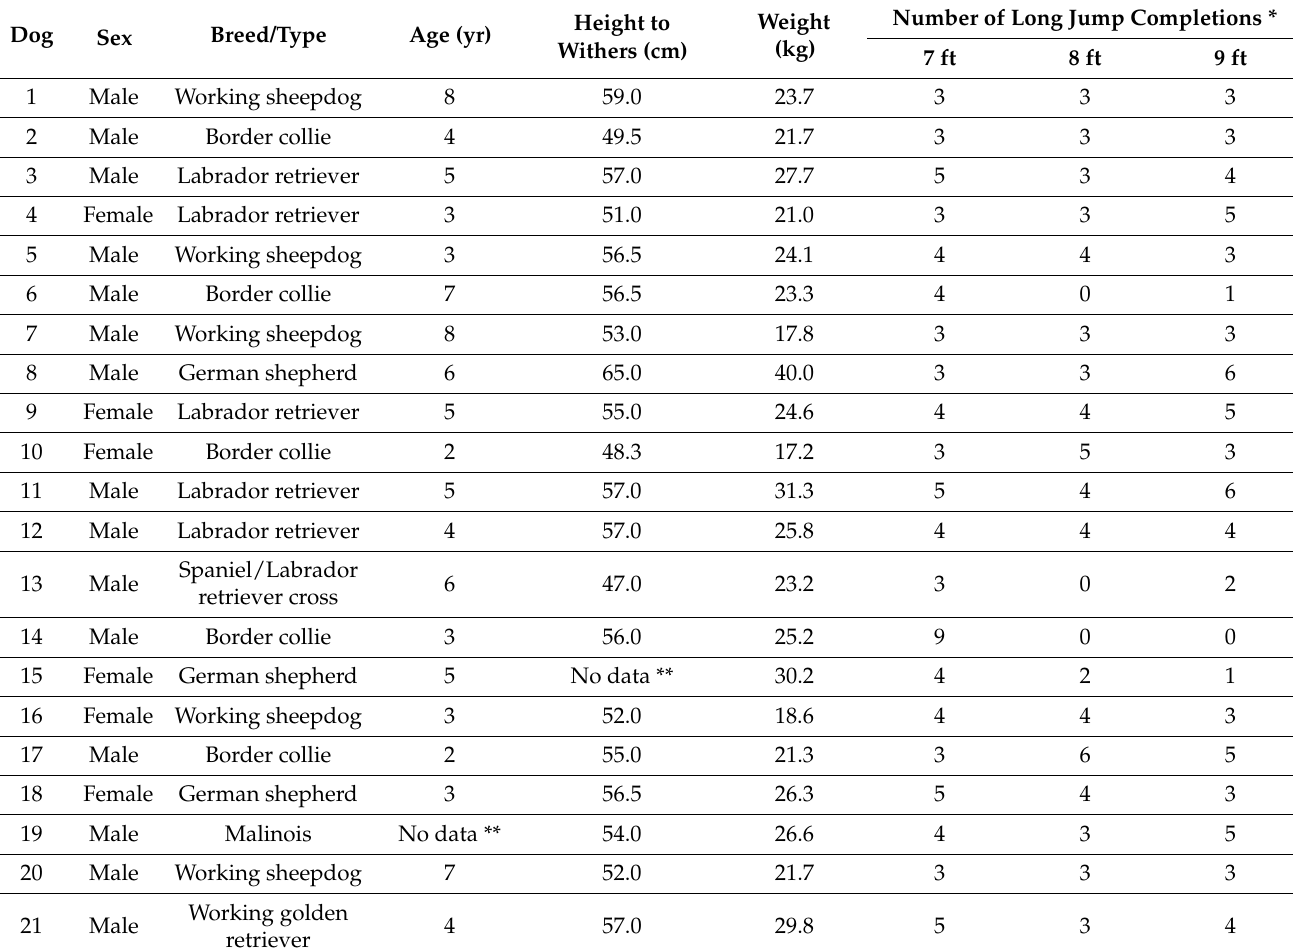
Table 1. Demographics of participating dogs (as per those detailed in Carter et al.